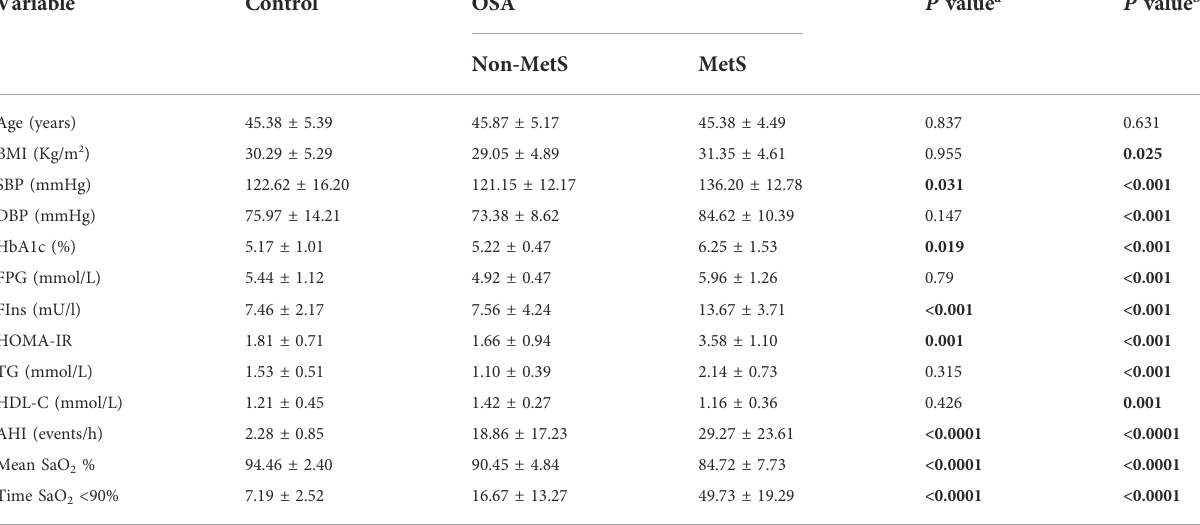
These bold values mean p < 0.05. Data are shown as mean ± SD (standard deviation). a/b p values are estimated between groups. a of control and OSA, or subgroups. b of OSA-non-MetS and OSA-MetS. BMI, bodymass index; fat mass,percentage of body fat;SBP, systolicblood pressure; DBP, diastolic blood pressure; HbA1c,glycosylatedhaemoglobin; FPG, fasting plasma glucose; FIns, fasting insulin; HOMA-IR, homeostasis model assessment of insulin resistance; TG, triglycerides; HDL-C, high-density lipoprotein cholesterol; AHI, apnea – hypopnea index; AI,